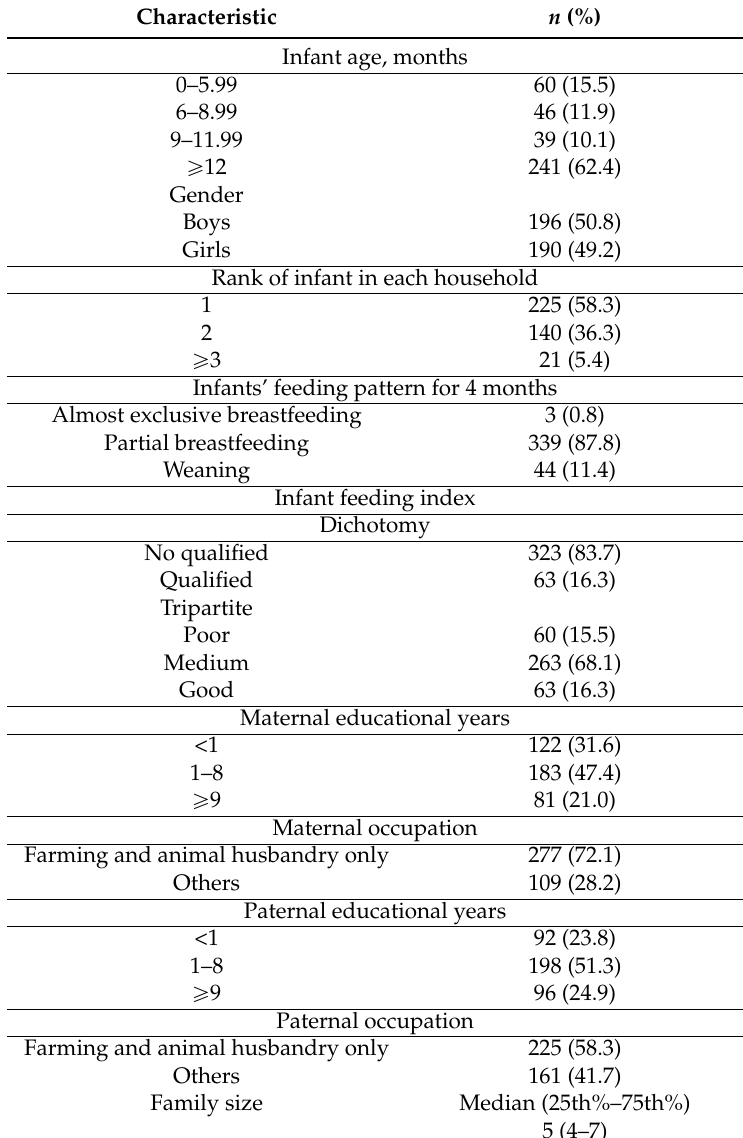
Table 3. Characteristics of selected